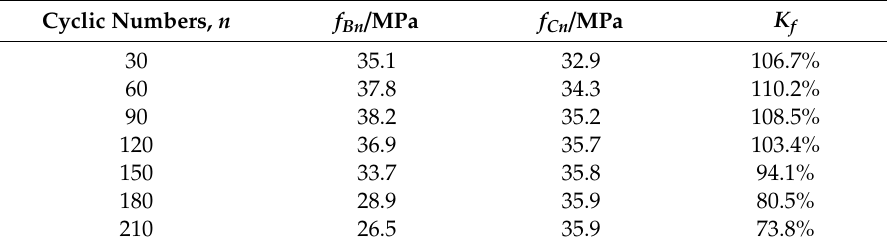
Table 4. Measured compressive strength and K f of structural EPS